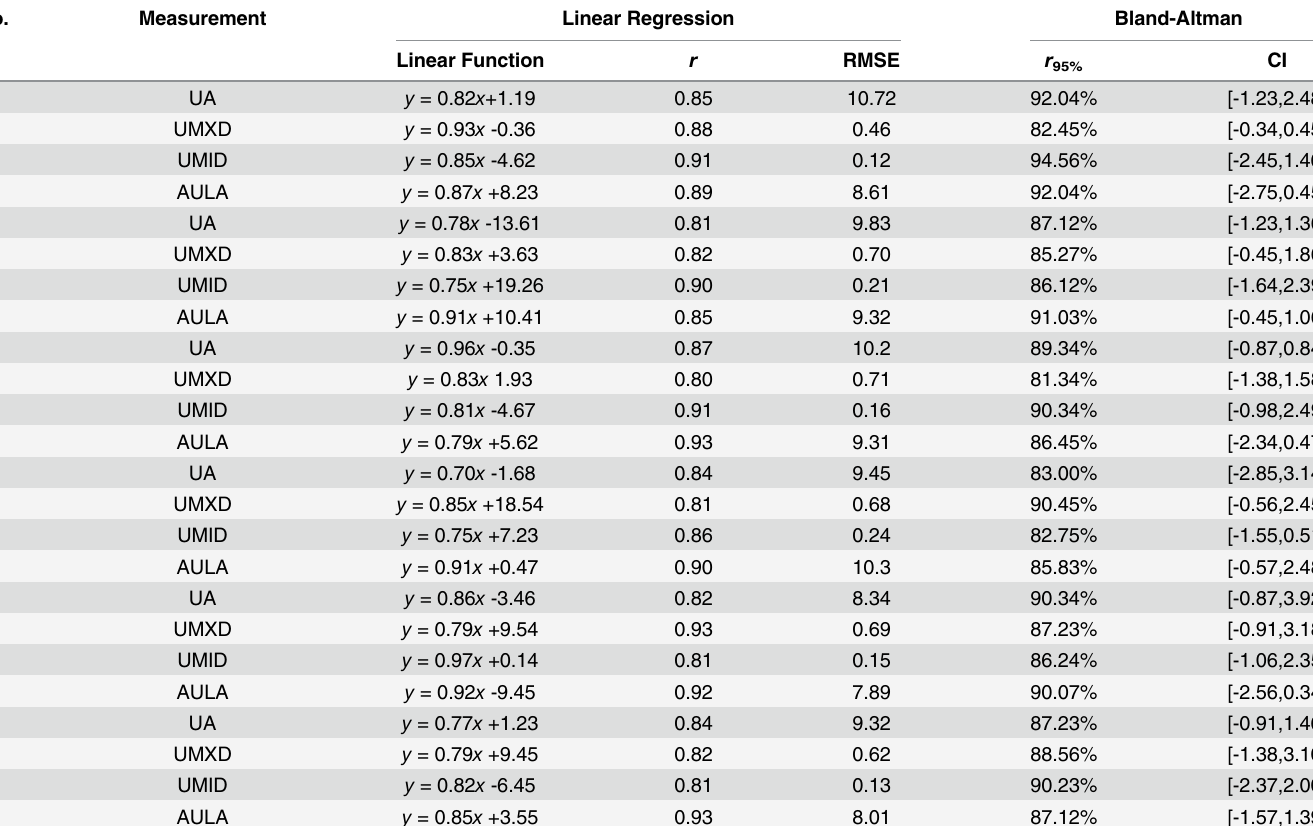
Table 1. The results of the linear regression and the Bland-Altman analysis.